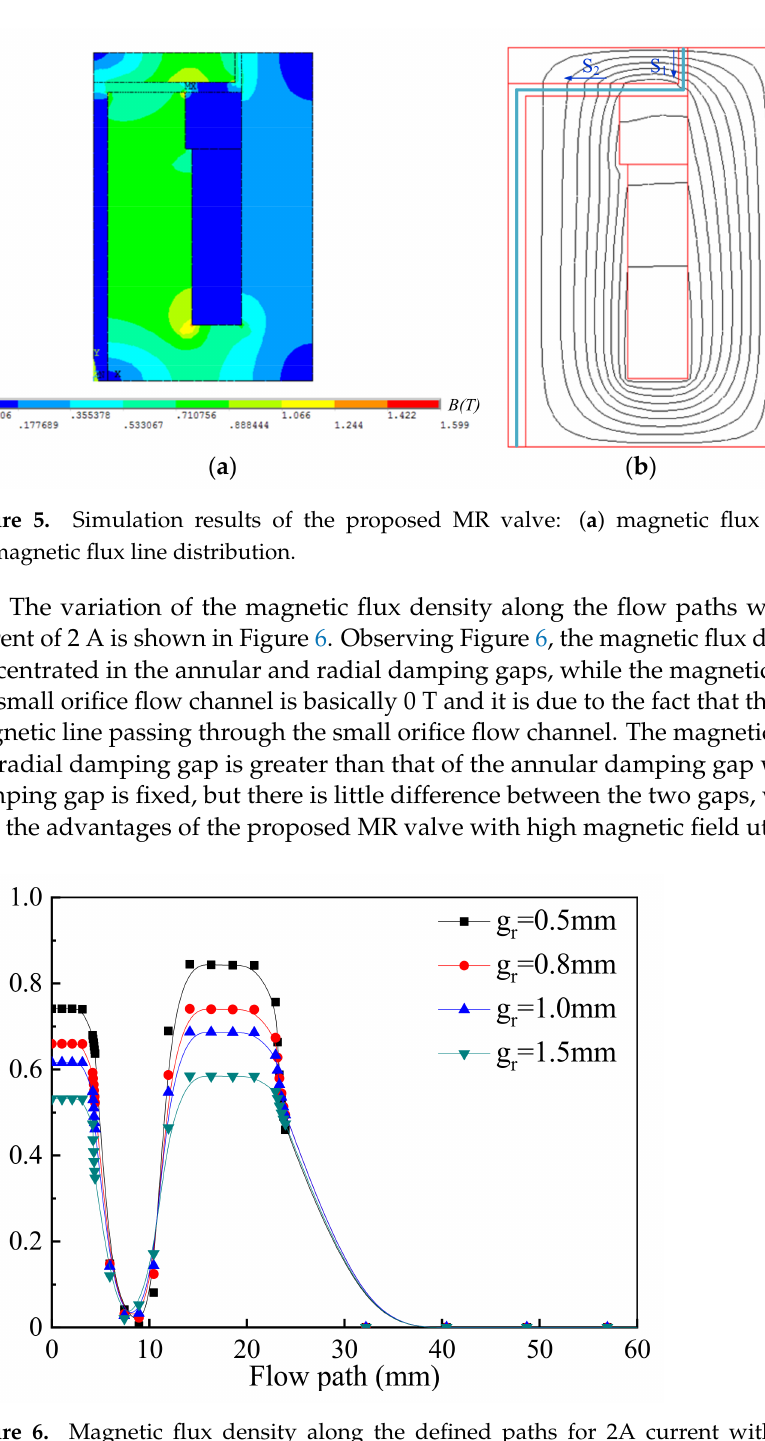
Figure 6. Magnetic flux density along the defined paths for 2A current with variable radial damping